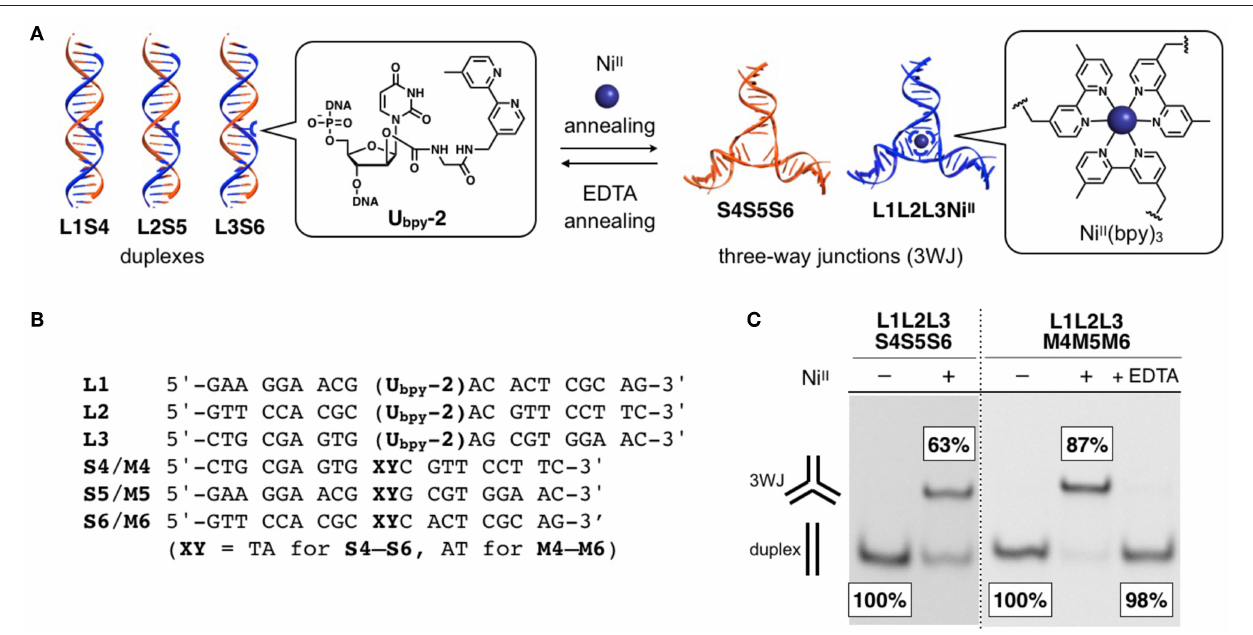
FIGURE 2 | (A) Schematic representation of metal-triggered structural transformation between DNA duplexes and three-way junctions (3WJs). (B) Sequences of the DNA strands used for the metal-triggered structural conversion. (C) Native polyacrylamide gel electrophoresis (PAGE) analysis of the mixture of DNA strands in the absence and in the presence of one equivalent of Ni II ions. “ + EDTA” indicates the result after the removal of Ni II ions by EDTA. Adapted from a literature ( Takezawa et al., 2016 ) published by The Royal Society of Chemistry under the Creative Commons CCBY